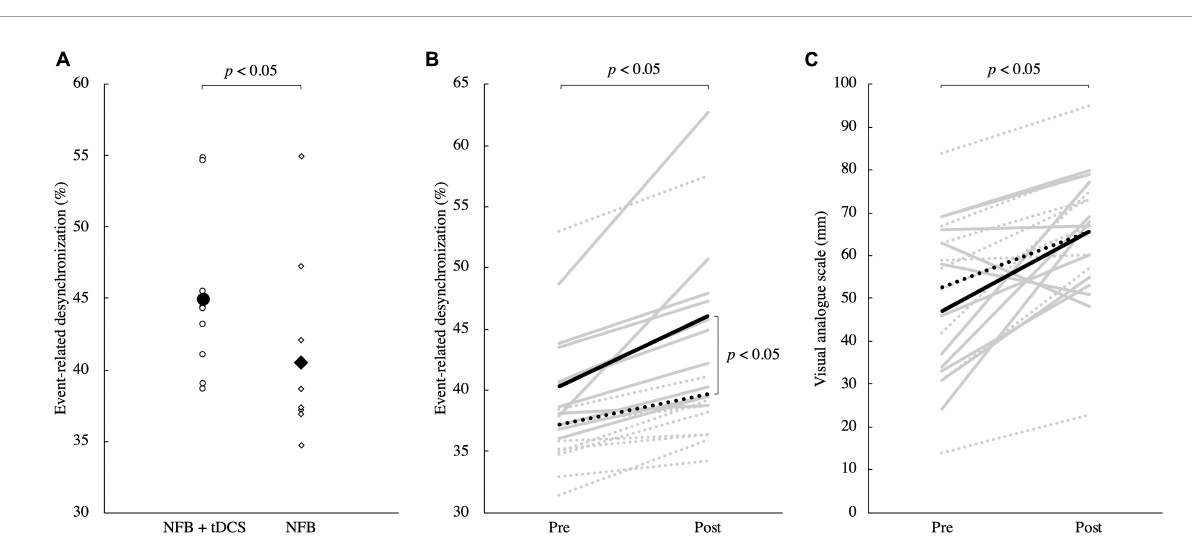
FIGURE4 (A) ERD in the training phase. Round markers indicate the NFB + tDCS group, and rhombic markers indicate the NFB group. The NFB + tDCS group had significantly higher ERD during MI in the training phase than the NFB group ( p < 0.05). (B) ERD changes between pre- and post-evaluation. The solid line shows the data for the NFB + tDCS group, and the dotted line shows the data for the NFB group. The gray line shows the data for each participant and the black line shows the mean for each group. There was a significant interaction between group and time, with a significant increase in ERD in the NFB + tDCS group compared to that in the NFB group ( p < 0.05). Furthermore, ERD after training was significantly higher in the NFB + tDCS group than in the NFB group ( p < 0.05). (C) Changes in VAS scores. The solid line shows the data for the NFB + tDCS group, and the dotted line shows the data for the NFB group. VAS increased after training in both groups ( p < 0.05). MI, motor imagery; NFB, neurofeedback; tDCS, transcranial direct current stimulation; ERD, event-related desynchronization; VAS, visual analog